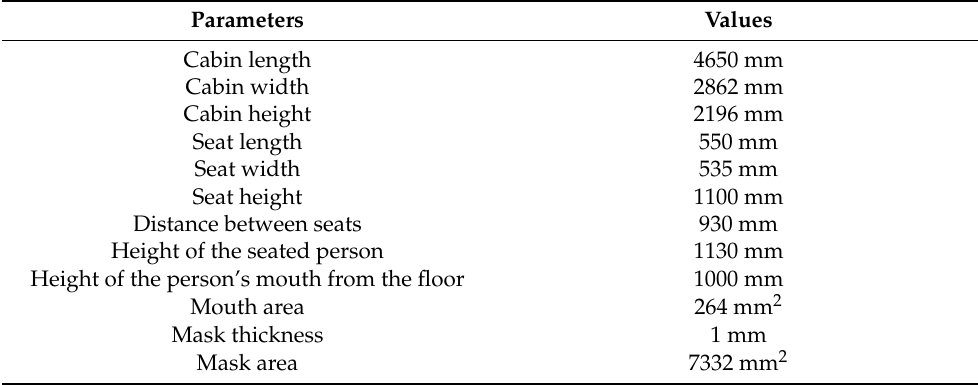
Table 2. Specifications of the high-speed train